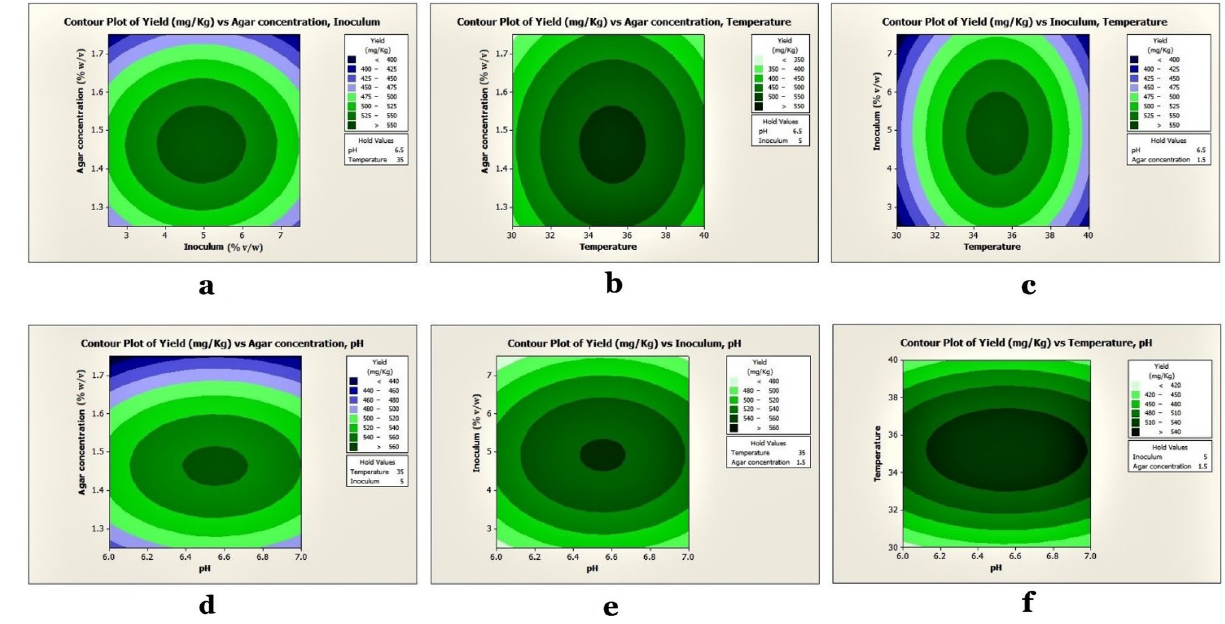
Figure 5. Contour plots of antimicrobial extract yield from UKAQ_23.